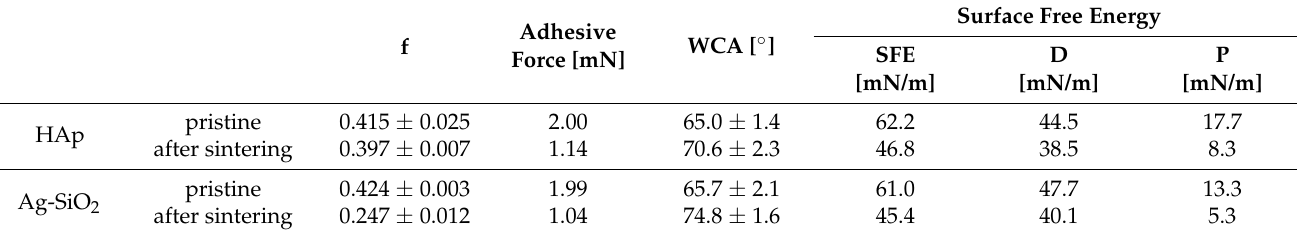
Table 1. Friction coefficient (f), adhesive force, water contact angle (WCA), total surface free energy (SFE) with the dispersive (D) and polar (P) components that were obtained for the pristine and sintered HAp and the Ag-SiO 2 coatings that were deposited on TiO 2 /NiTi. The standard deviation was estimated based on five